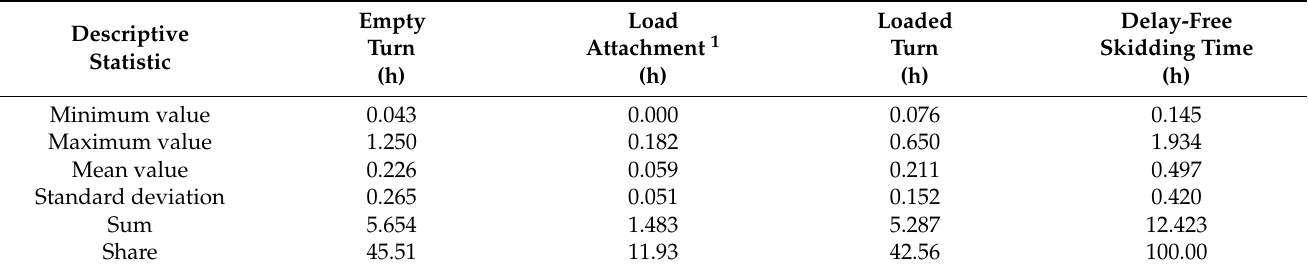
Table 4. Statistics of elemental time consumption within a delay-free skidding work cycle.